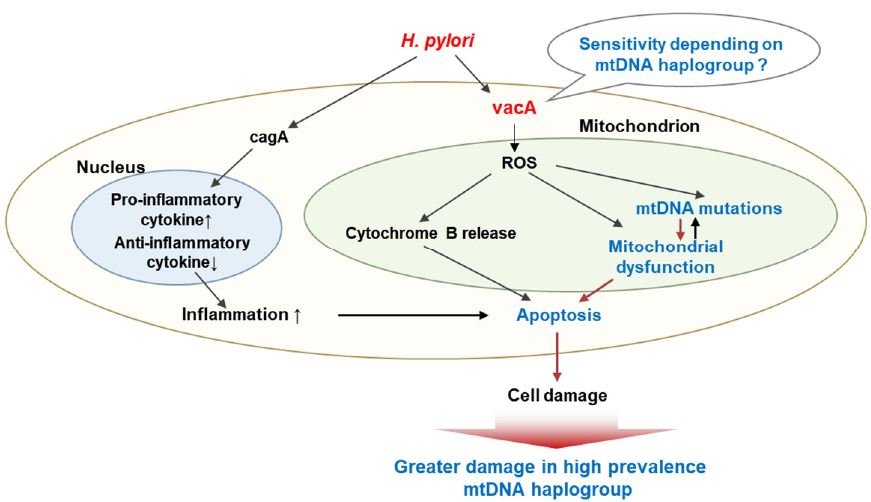
Figure 6. mtDNA mutations in each haplogroup of the H. pylori -positive populations. ( A ) Number of mtDNA mutations of functional regions in the H. pylori -positive population. Haplogroup B was found to have a higher number of mtDNA mutations than that of haplogroup D, but the difference was not significant. ( B ) Increased heteroplasmy in functional regions in the H. pylori -positive population. Average heteroplasmy of mtDNA mutations was significantly higher in haplogroup B than in that of haplogroup D (* p < 0.05).